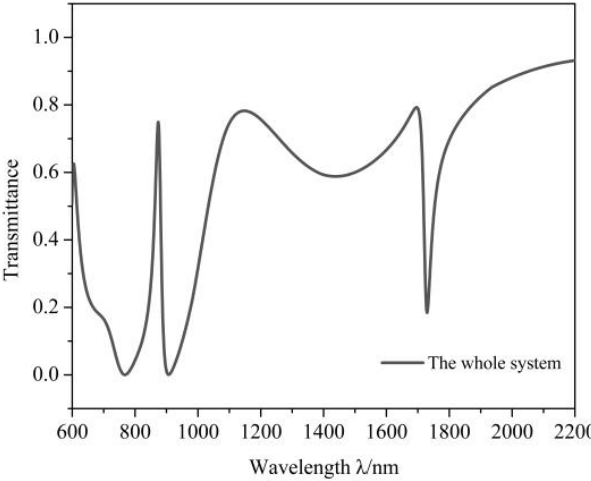
Figure 3. Transmission spectrum of the system. The FWHM of F 2 is narrower than that of F 1 , but the sensitivity of F 2 getting 840 nm/RIU lower than that of F 1 that is 1320 nm/RIU. Therefore, we choose F 1 as the object of this